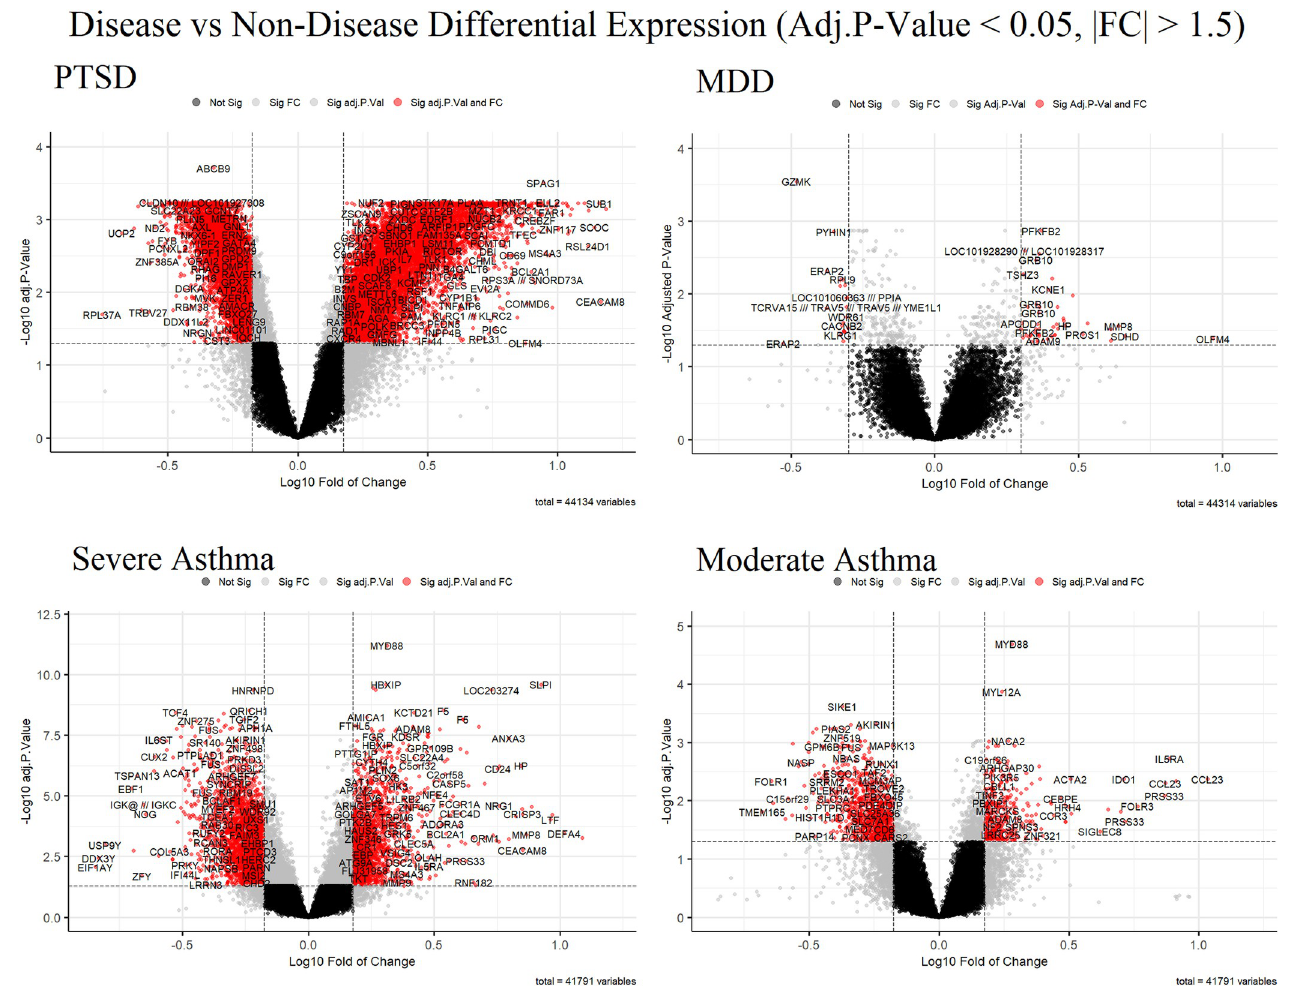
Fig 2. mRNA from the blood of subjects with a disease (PTSD, MDD, severe asthma, and moderate asthma) were compared to blood mRNA from non- diseased subjects for each exploration cohort dataset. The vertical threshold denotes genes or transcripts that are statistically significant (adjusted p- value < 0.05) while the horizontal threshold denotes genes or transcripts with an absolute fold change greater than 1.5. Genes or transcripts that meet none of these criteria are black, one of these criteria are grey, and both are red. The red genes, found to be significant, are also shown next to their